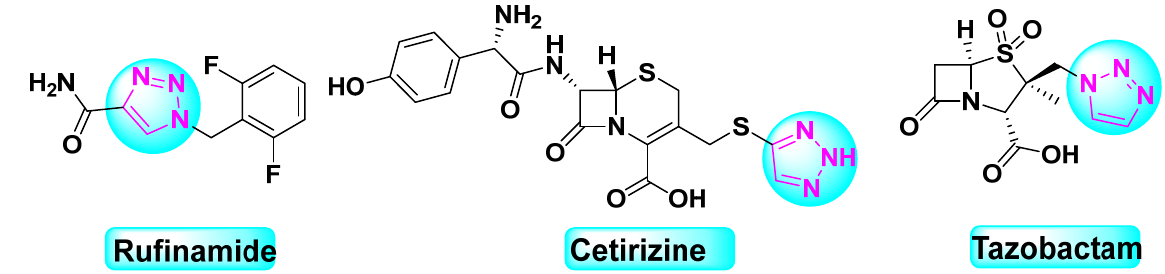
Figure 1. Drugs with the 1,2,3-triazole unit on the market.